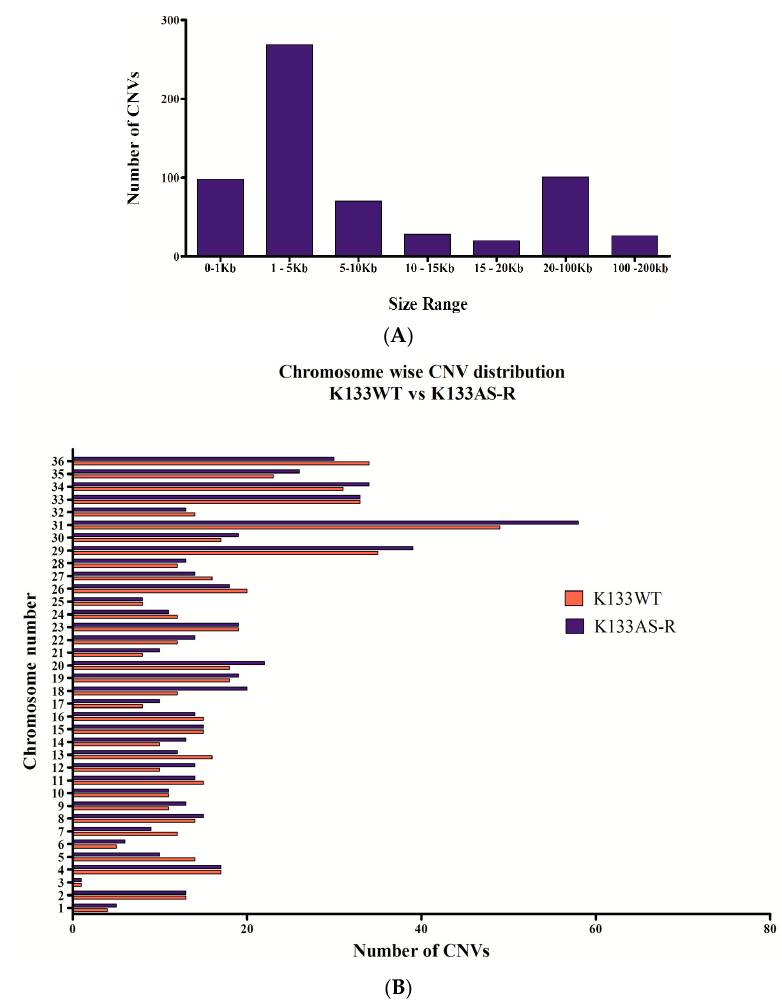
Figure 2. Analysis of CNV diversity in artesunate-resistant L.donovani (K133AS-R). ( A ) Size distribution of CNVs detected in the K133AS-R genome ( B ) Comparative CNV analysis of K133WT vs.